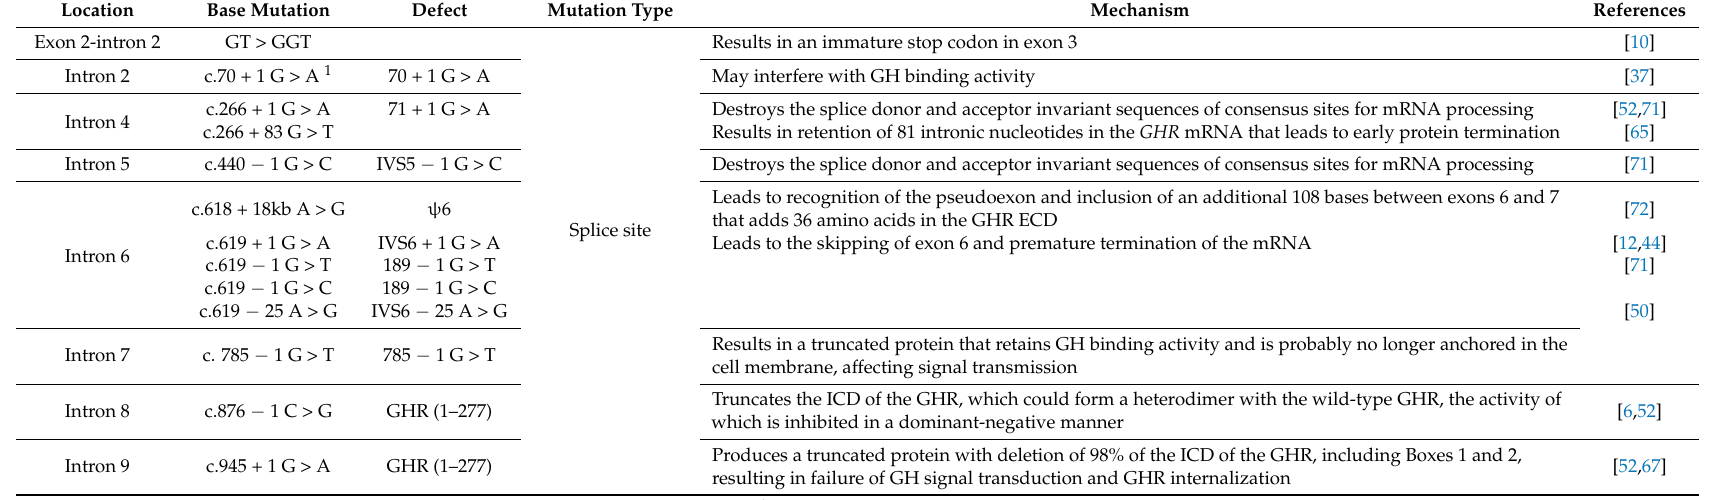
Table 5. Mutations in introns of GHR relevant to human dwarfism due to the failure of GHR